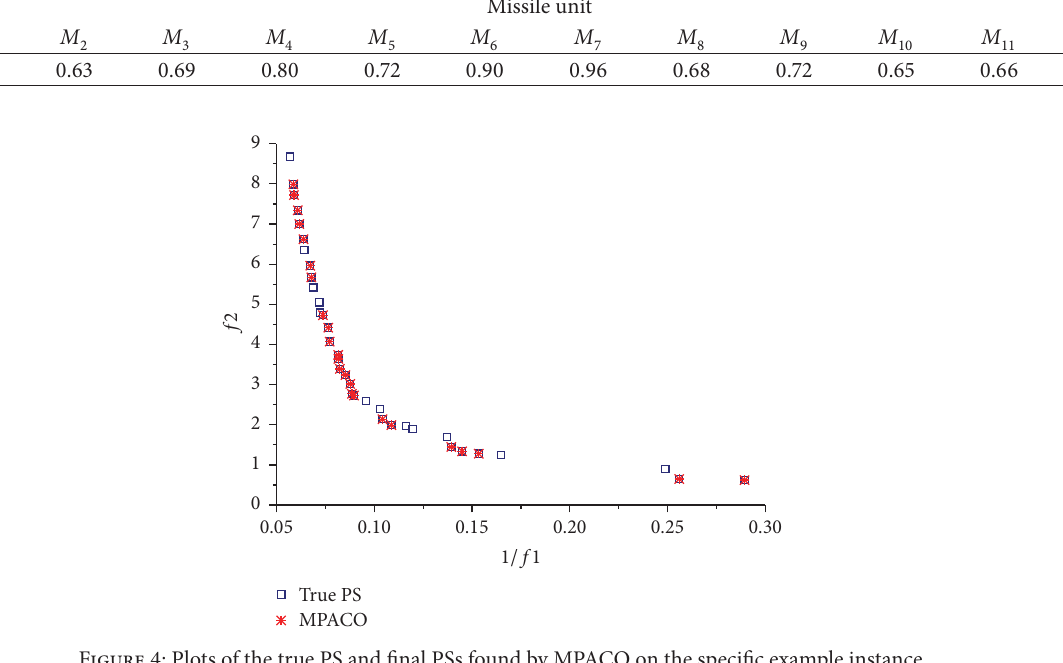
Figure 4: Plots of the true PS and final PSs found by MPACO on the specific example instance.